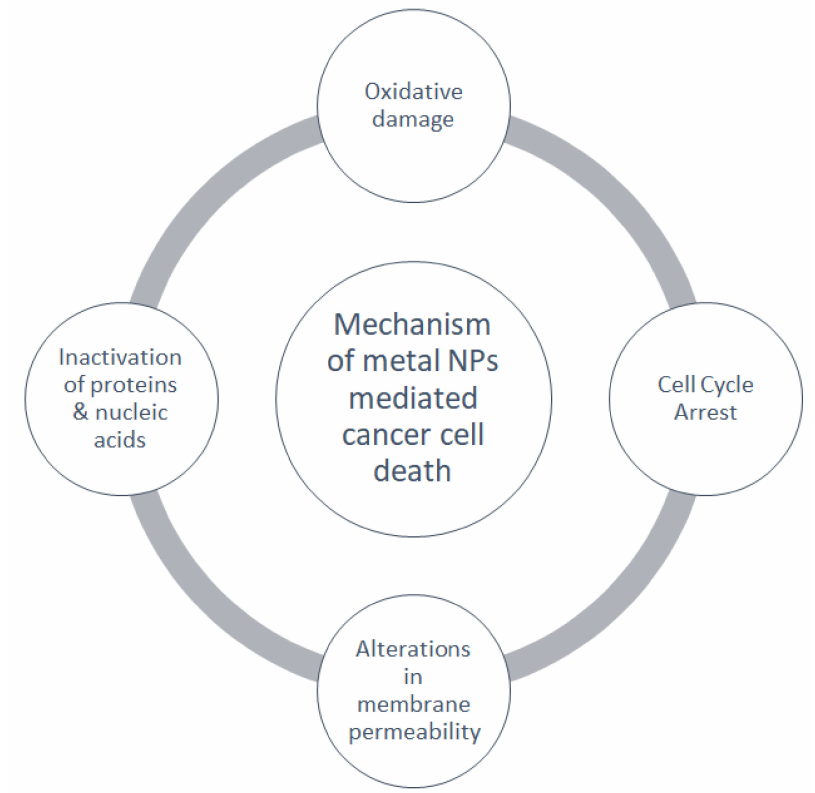
Figure 6. Mechanism of metal nanoparticle-mediated cell